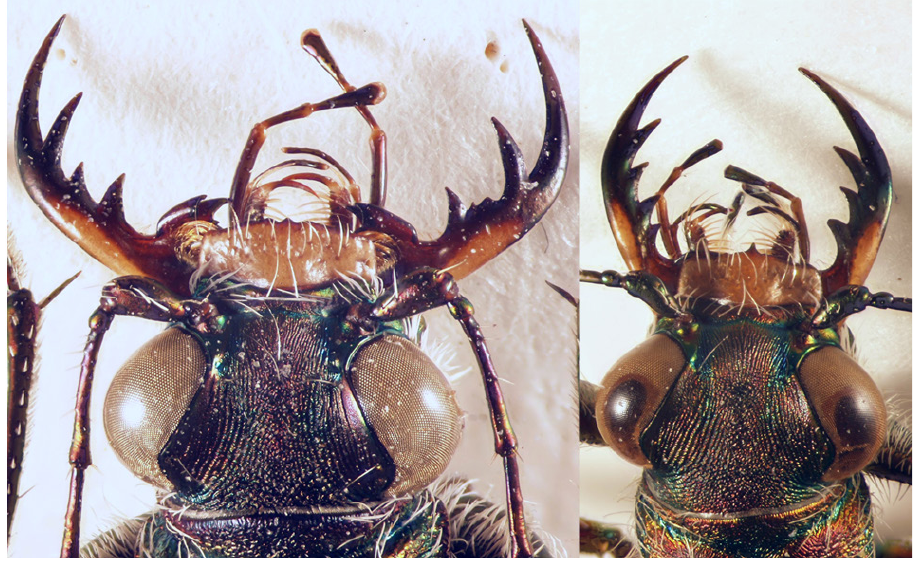
Figure 51. Head of Calomera species in dorsal view: C. aphrodisia (left), C. aulicoides (right). Three species are listed from the southern Levant, but their occurrence is ques- tionable as verifiable records are missing: Calomera fischeri, Cephalota circumdata and Cephalota